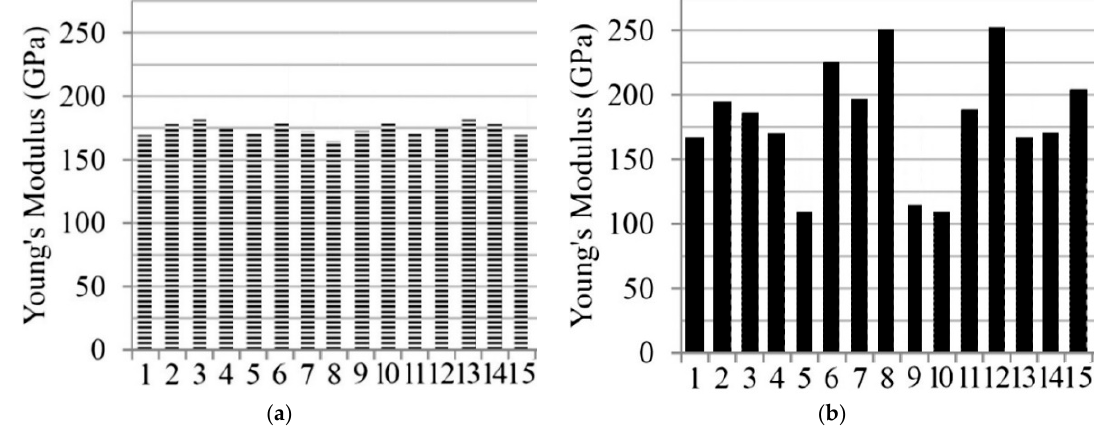
Figure 5. Distribution of the Young’s modulus: ( a ) Updated model F; ( b ) Updated model FMS1 [45].